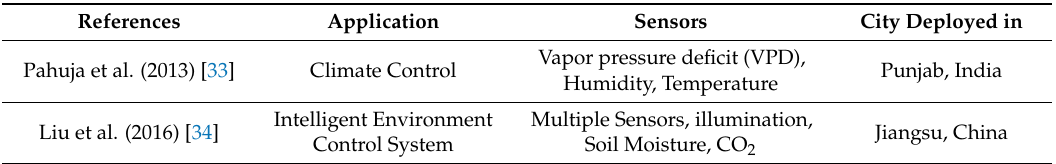
Table 2. Examples of prototyped applications for greenhouse